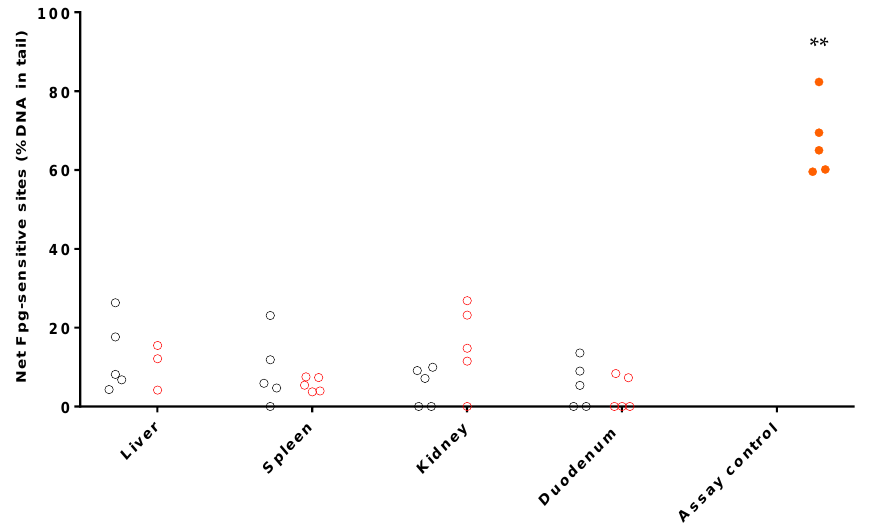
Figure 3. Results of the in vivo Fpg-modified comet assay in frozen samples of liver, spleen, kidney, and duodenum, after 28-day oral administration of the silver-kaolin formulation. The graphic shows the Fpg-sensitive sites in terms of % DNA in tail of each five animals composing negative control (grey), 2000 mg/kg b.w. (red) and assay control (full orange). ** ( p < 0.01) statistically significant different from negative control.